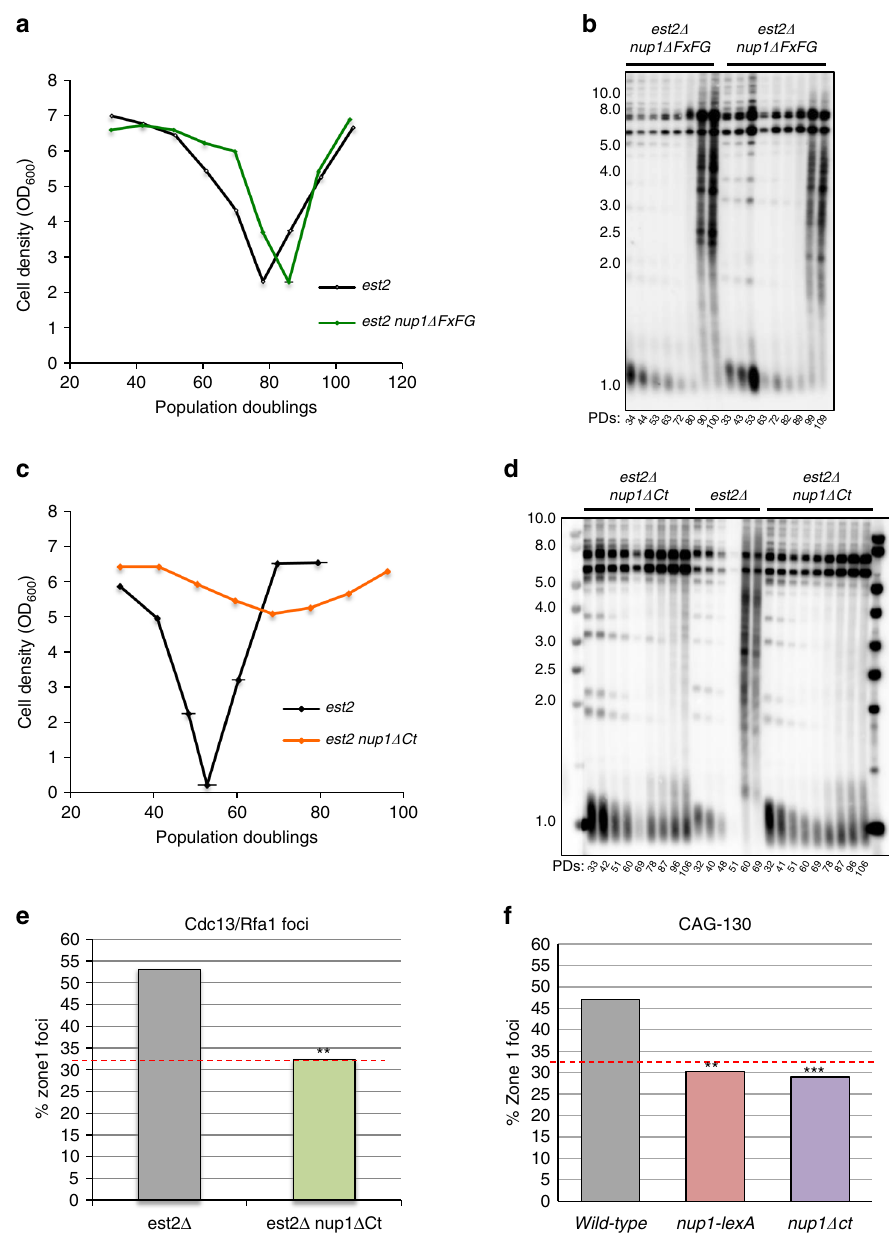
Fig. 7 nup1 Δ Ct phenocopies the phenotypes of nup1-LexA . a Mean senescence pro fi les of est2 Δ ( n = 5) and est2 Δ nup1 Δ FxFG ( n = 5) clones. Error bars are SD. b Telomere length analysis of two representative est2 Δ nup1 Δ FxFG clones. Southern blot of XhoI -digested DNA prepared from samples of senescing cells was revealed with a TG 1 – 3 probe. c Mean senescence pro fi les of est2 Δ ( n = 4) and est2 Δ nup1 Δ Ct ( n = 8) clones. Error bars are SD. d Telomere length analysis of representative clones of the indicated genotypes. e The localization of the Cdc13-YFP/Rfa1-CFP foci in the three zones of equal area of the nucleus marked by Nic96-RFP was scored in late S and G2/M est2 Δ and est2 Δ nup1 Δ Ct cells as described in Fig. 2. The percentages of zone 1 foci are from three independently isolated est2 Δ nup1 Δ Ct ( n = 139 cells) clones. WT cells are from Fig. 3. Statistical differences were determined by a Fisher ’ s exact test (** p = 0.0019). f Percent of zone 1 foci for CAG-130 S-phase in nup1 Δ Ct cells ( n = 143). Statistical differences were determined by a Fisher ’ s exact test (*** p = 0,0006). WT and nup1-LexA cells are from Fig. 3. The repartition of the Rfa1/Cdc13 and CAG-130 foci between the three zones of the nucleus is shown in the Supplementary Fig.